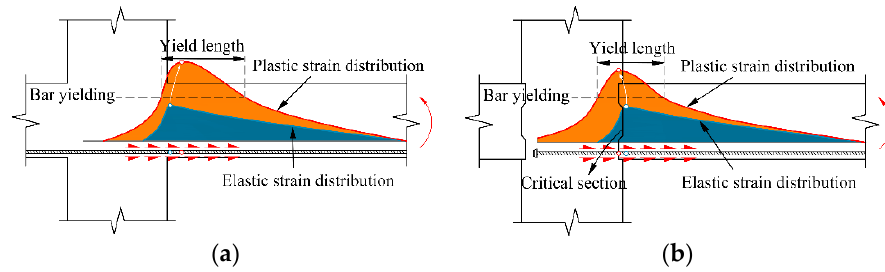
Figure 5. Comparison of rebar strain: ( a ) RC joint; ( b ) monolithic precast joint.